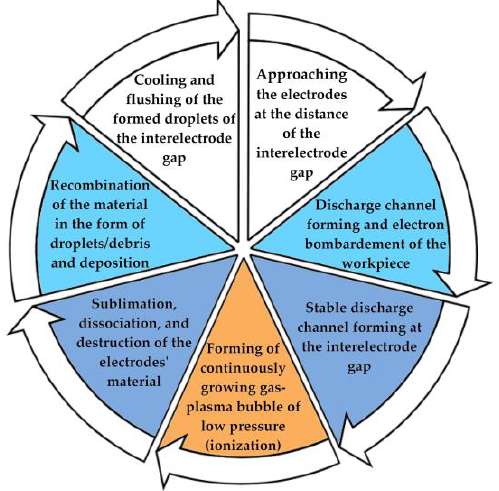
Figure 14. Physical phenomena accompany electrical discharge